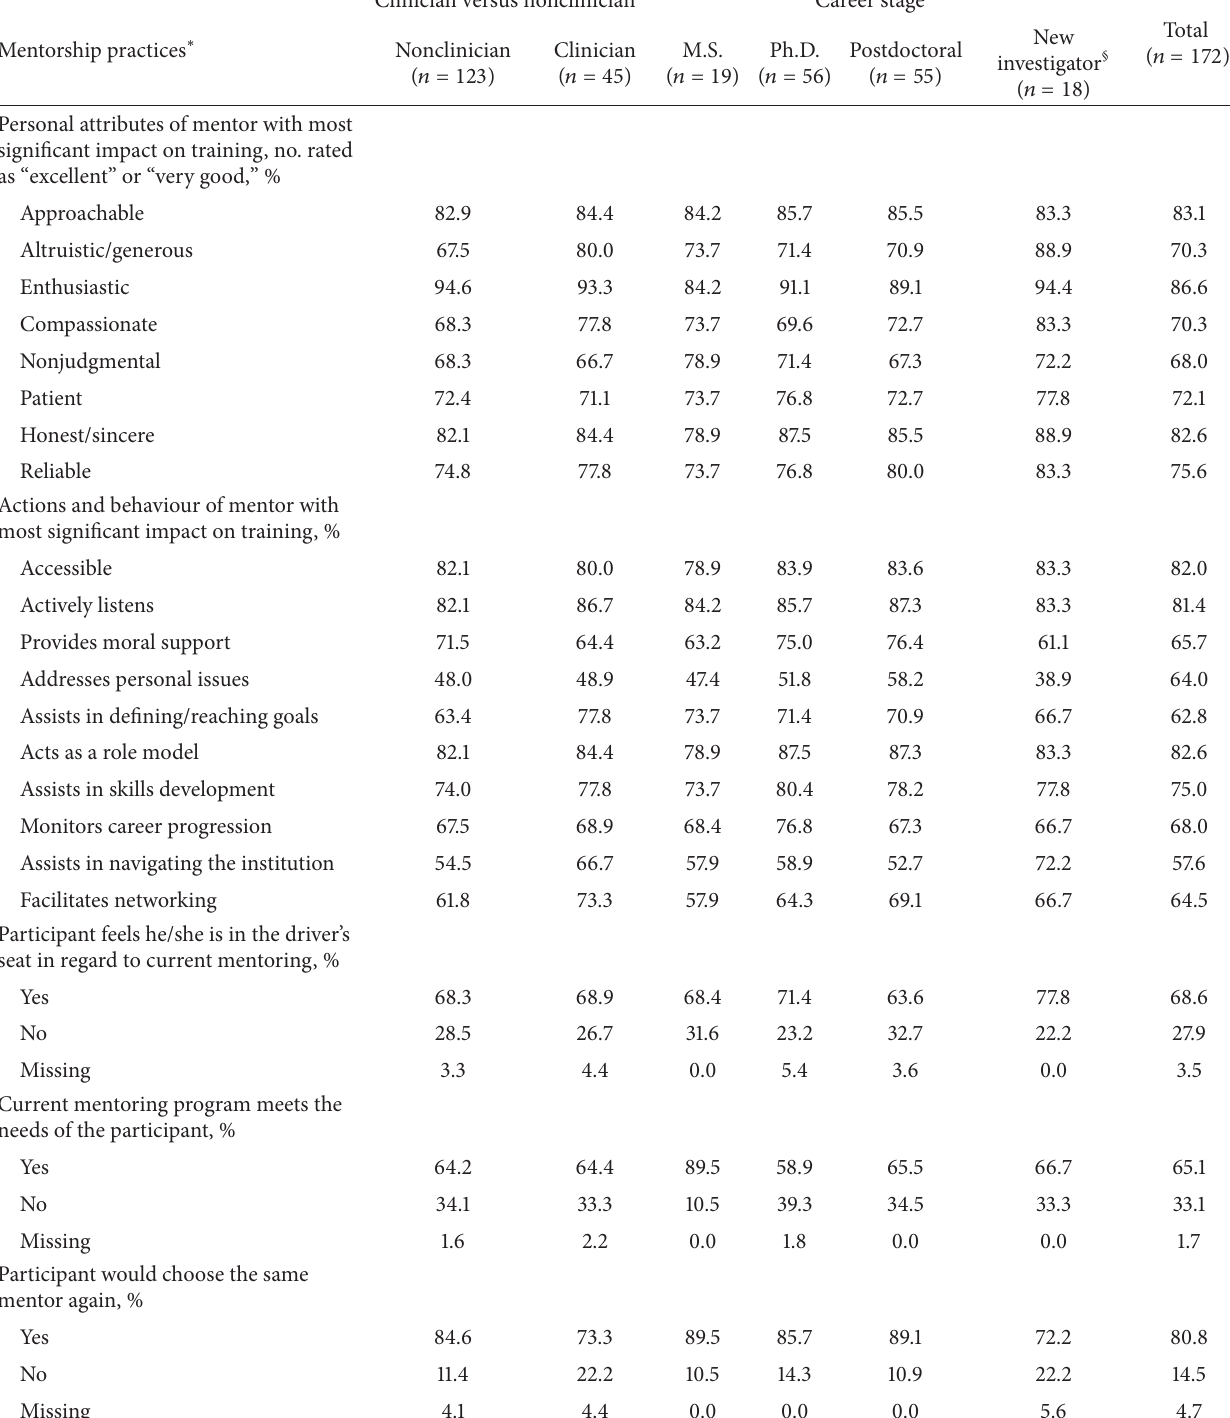
Table 3: Participant appraisal of current mentoring